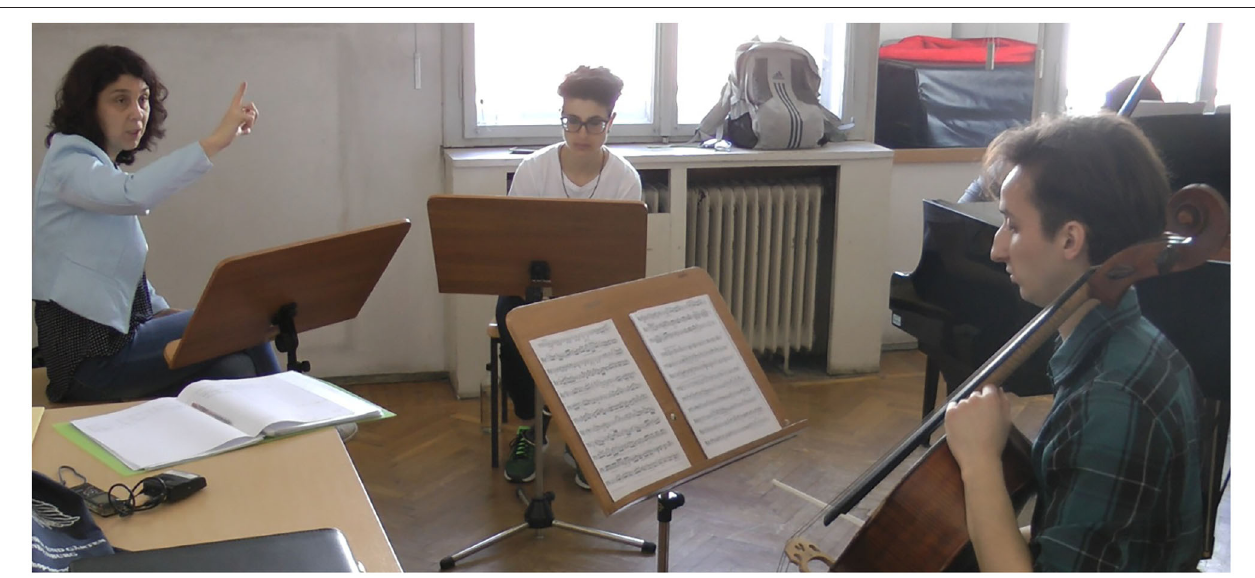
FIGURE 5 | Professor traces a semicircle with right